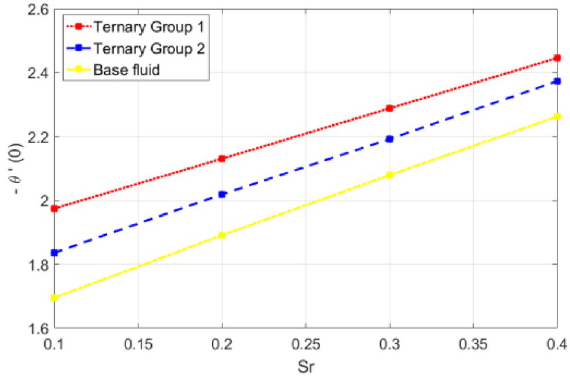
Figure 21. Deviation in Nusselt number against Soret number (Sr).